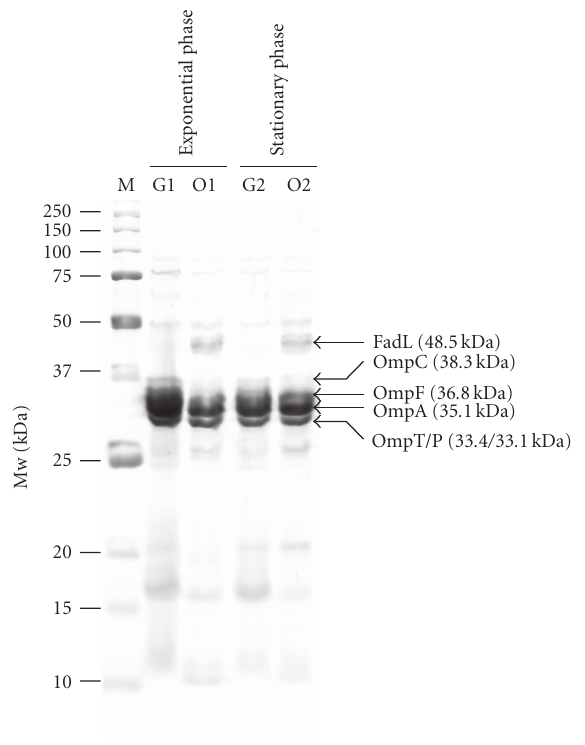
Figure 3: SDS-PAGE of the outer membrane proteins taken from samples of proteome. Identified proteins are shown on the right side. Size markers (in kDa) are indicated on the left.